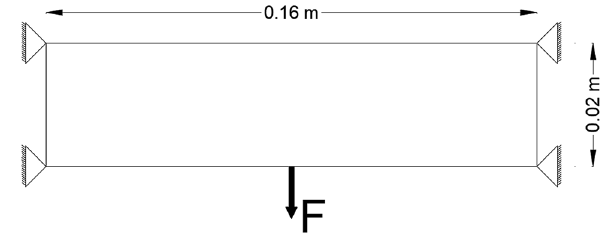
Figure 2. Simply supported plate benchmark problem.